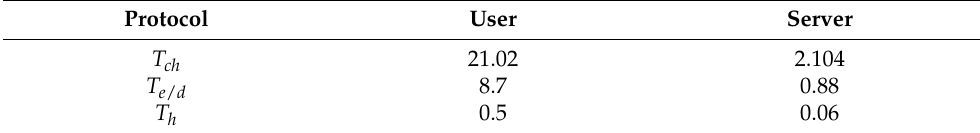
Table 7. Running time of operations